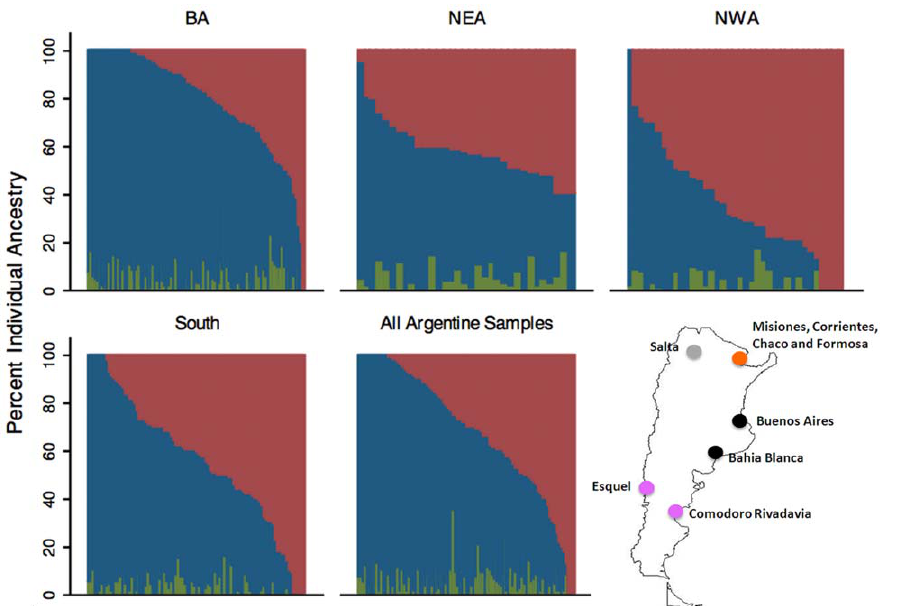
Figure 1. Distribution of genetic ancestry among 441 individuals from Argentina by four major regions. Each individual is represented by a vertical bar on the X-axis. Bars are divided into percent European (blue), Indigenous American (red) and African ancestry (green). BA=Buenos Aires province; NEA=Northeast; NWA=Northwest; South=South. Individuals on the X-axis are sorted based on increasing Indigenous American ancestry. On the lower right corner we include a map of Argentina indicating the location of the samples. For analysis we grouped samples by region: black: BA, pink: South, grey: NWA, orange: NEA. Samples of individuals from the NEA region (orange) were obtained from the hospitals in Buenos Aires.